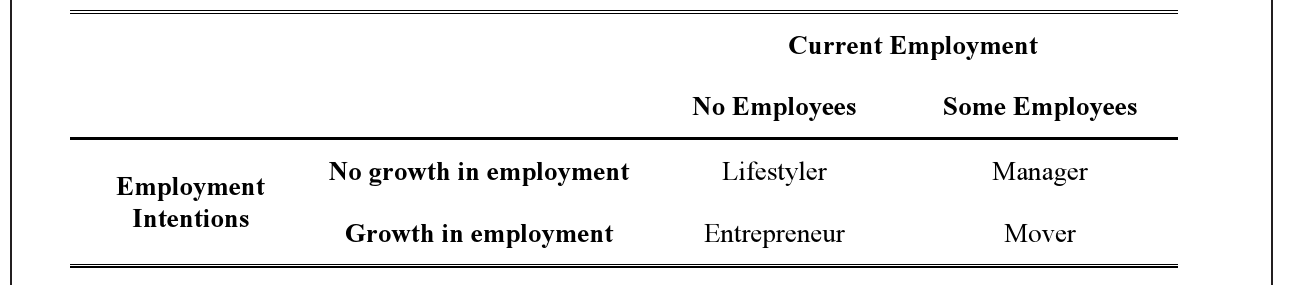
Figure 1. Classification of Young Microenterprises